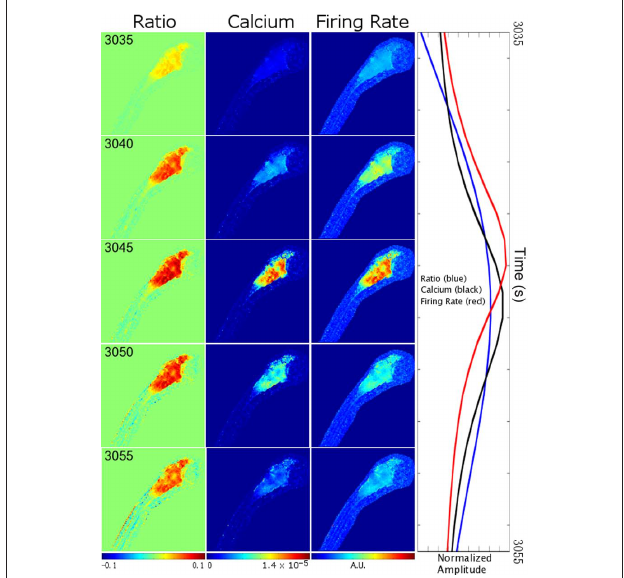
Figure 3 | estimating firing rates from ratiometric Ca 2 + imaging data. Background subtracted YFP/CFP ratios, and associated Ca 2 + concentrations and firing rates are depicted for the same laterally mounted 7 dpf zebrafish larva as was depicted in Figure 1 . Snapshots from 20 s of data are shown at 5 s intervals with time running from top to bottom. The left column depicts the background subtracted YFP/CFP ratio estimated using the SOARS method. Numbers in the upper left denote the number of seconds from the beginning of the experiment. The middle left column depicts intracellular Ca 2 + concentrations calculated from the ratios in the left column (see Materials and Methods). The middle right column depicts firing rates deconvolved from the Ca 2 + concentrations in the middle left column (see Materials and Methods). Normalized time-courses (mean subtracted, divided by SD) showing relative timing of peaks and shapes of the ratio, calcium and firing rates for the ROI depicted in Figure 1A are shown in the right-hand column. CNS regions and scale are given in Figure 1A . See Supplemental Information for a complete movie of the entire